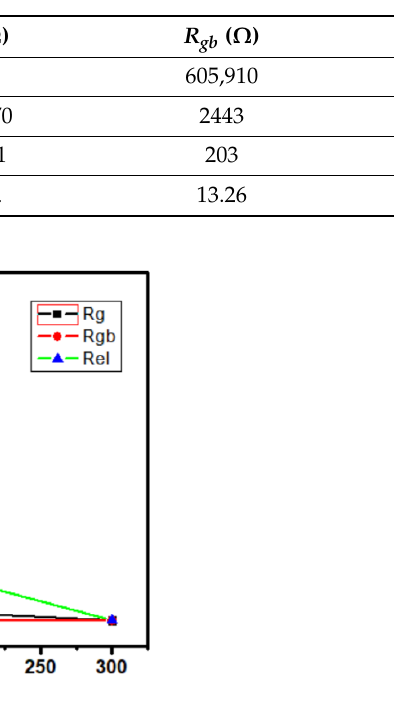
Figure 6. Variation of R g , R gb , and R el depending on the temperature for the compound Ca 2 Fe 2 O 5